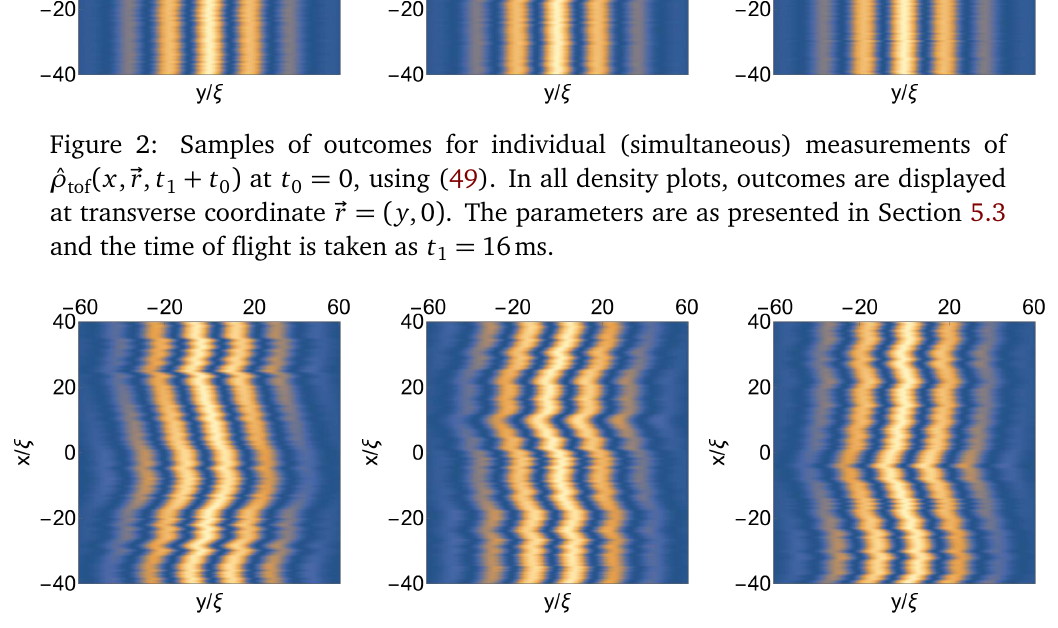
Figure 3: Samples of outcomes for individual (simultaneous) measurements of ( x , (cid:126) r , t + t ) at t = 14 ξ/ v ≈ 10.6ms, using (49). The parameters are as pre- ˆ ρ tof 1 0 0 sented in Section 5.3 and the time of flight is taken as t